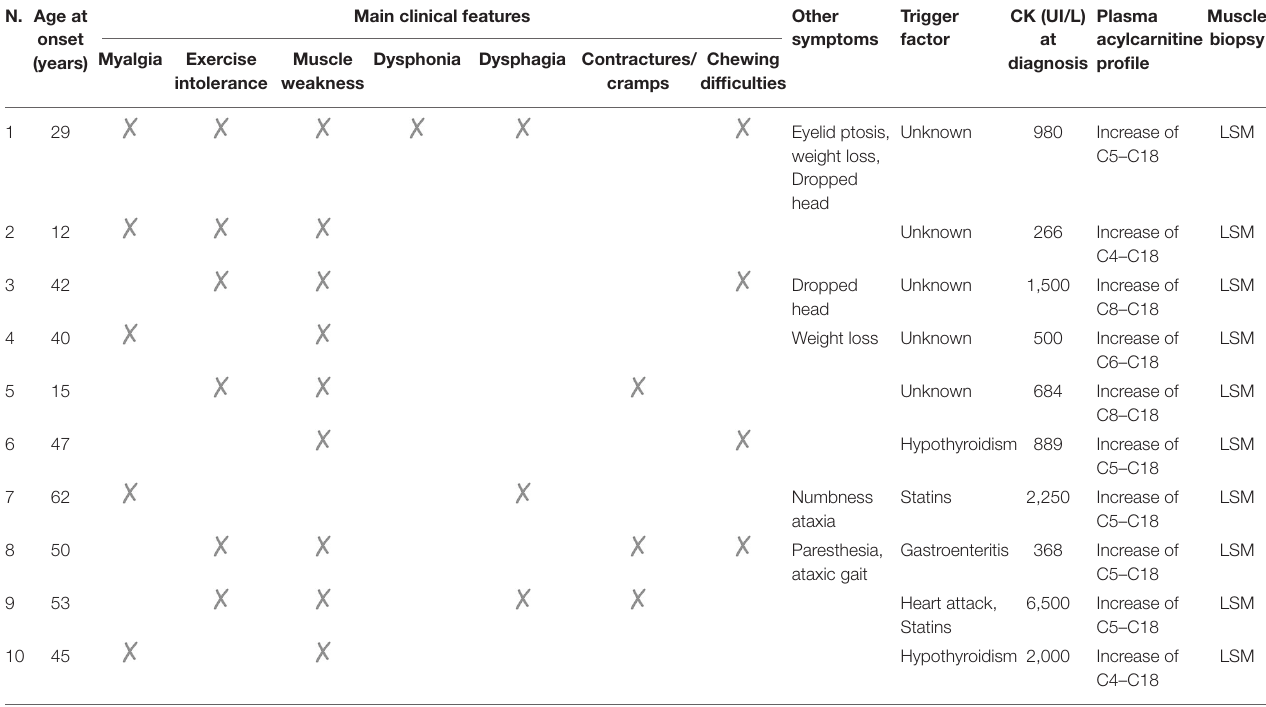
TABLE 1 | Clinical, biochemical, and morphological features in 10 patients with MADD. N. Age at onset